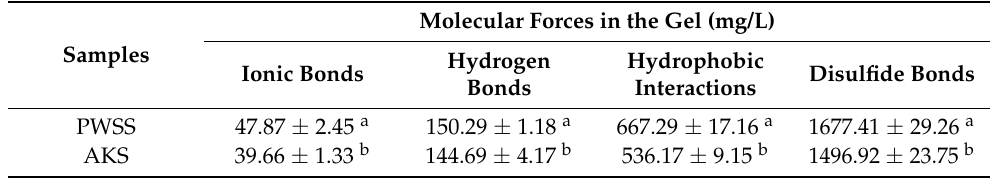
Table 1. Molecular forces involved in Antarctic krill and Pacific white shrimp surimi gels. Molecular Forces in the Gel (mg/L) Samples Hydrogen Ionic Bonds